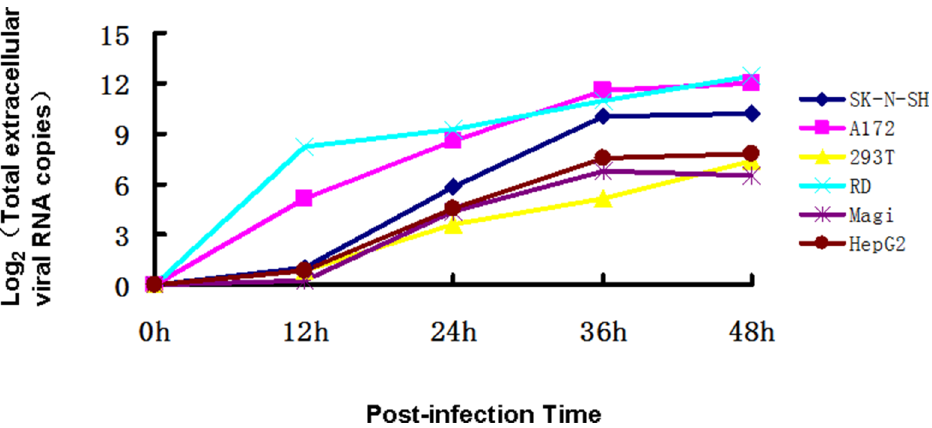
Figure 8. Replication kinetics of CA16 in diverse cell lines. RD, Magi, HEK293T, HepG2, A172 and SK-N-SH cell lines were infected with CA16 SHZH05 virus at the MOI of 0.2 for 1 h, and viral supernatants were collected at various time points post-infection. Extracellular virus RNA copy numbers were determined by RT-qPCR at 0 h, 12 h, 24 h, 36 h and 48 h. The CA16 RNA copy number at 1 h was set as zero. Each point represents the mean 6 SD of three separate experiments